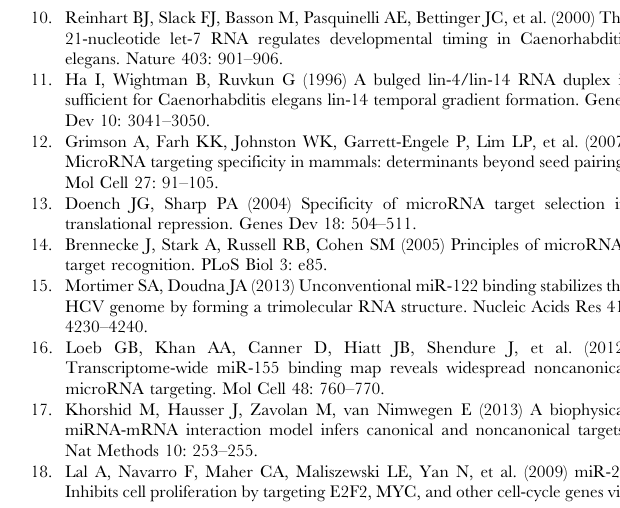
qPCR/qRT-PCR expression